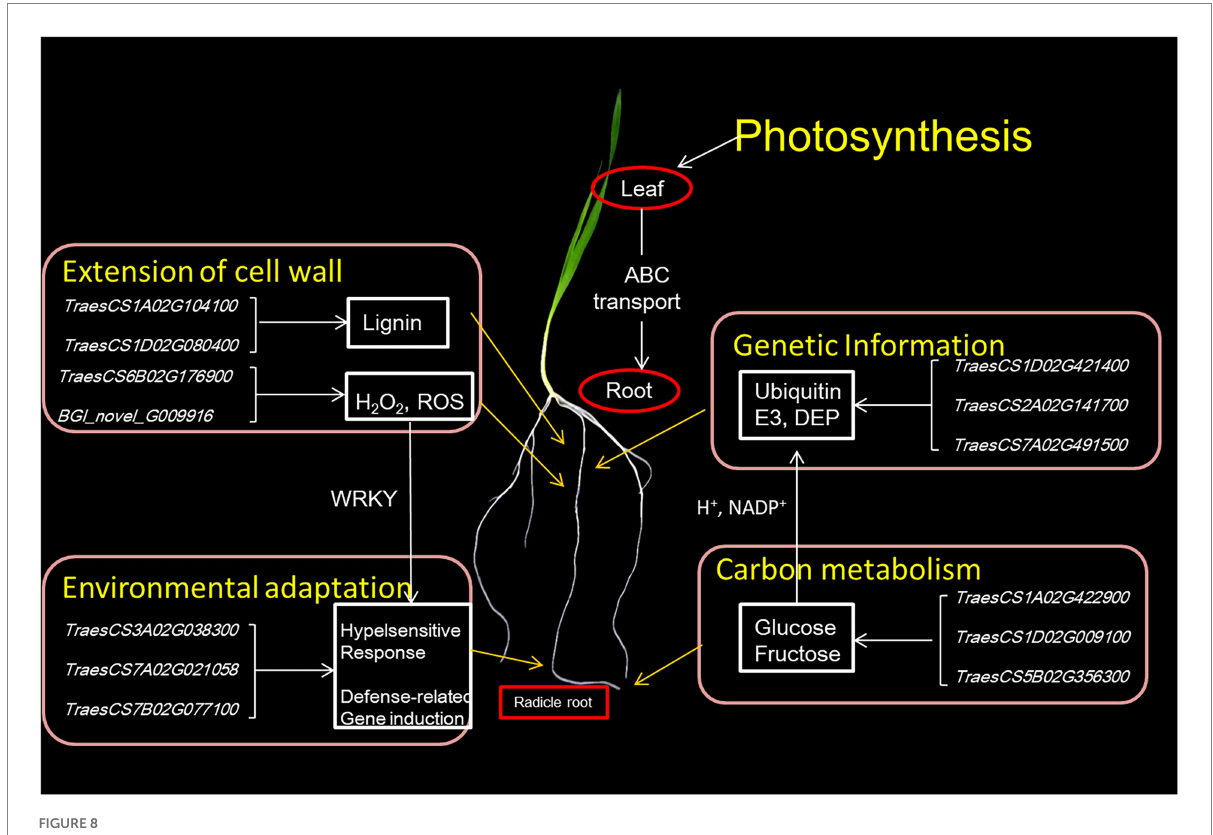
FIGURE 8 A molecular regulatory model controlling wheat radicle